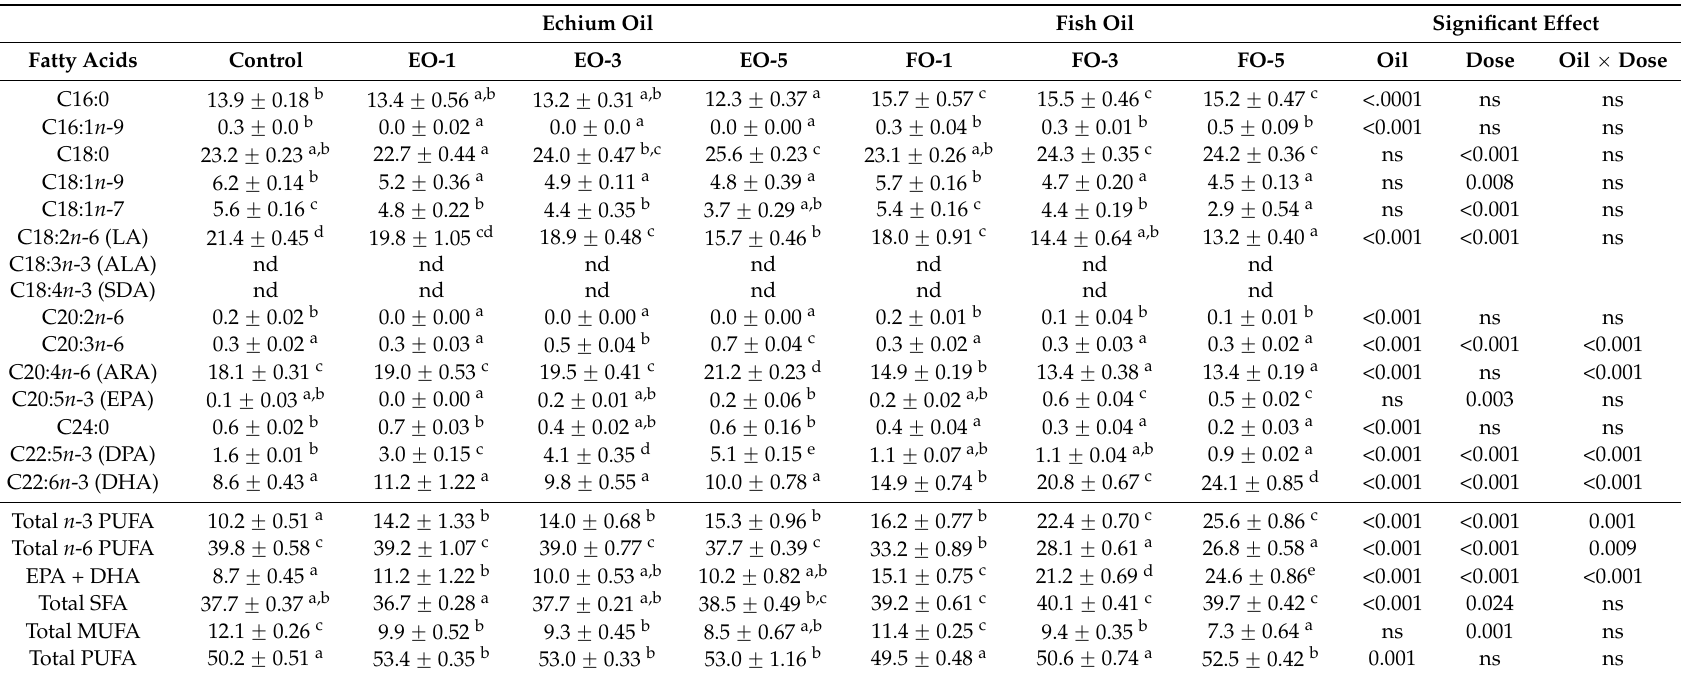
Table 3. Heart phospholipid fatty acid composition in rats fed diets supplemented with Echium oil or Fish oil. Echium Oil Fish